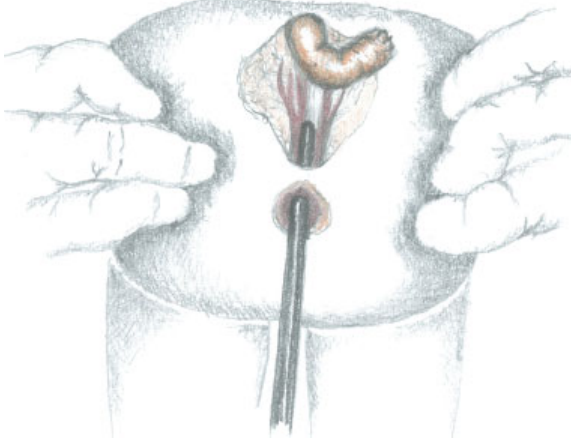
Fig. 6 Progressive dilation of the tunnel created in the center of the sphincter complex.